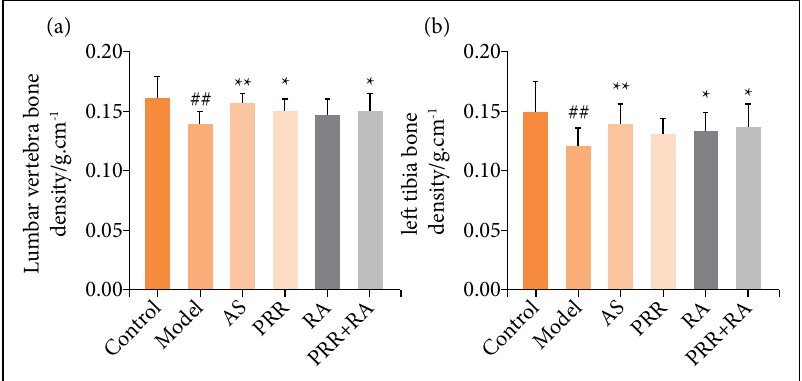
Figure 2 - Comparison of bone mineral density in various groups of rats after 12 weeks of drug intervention #